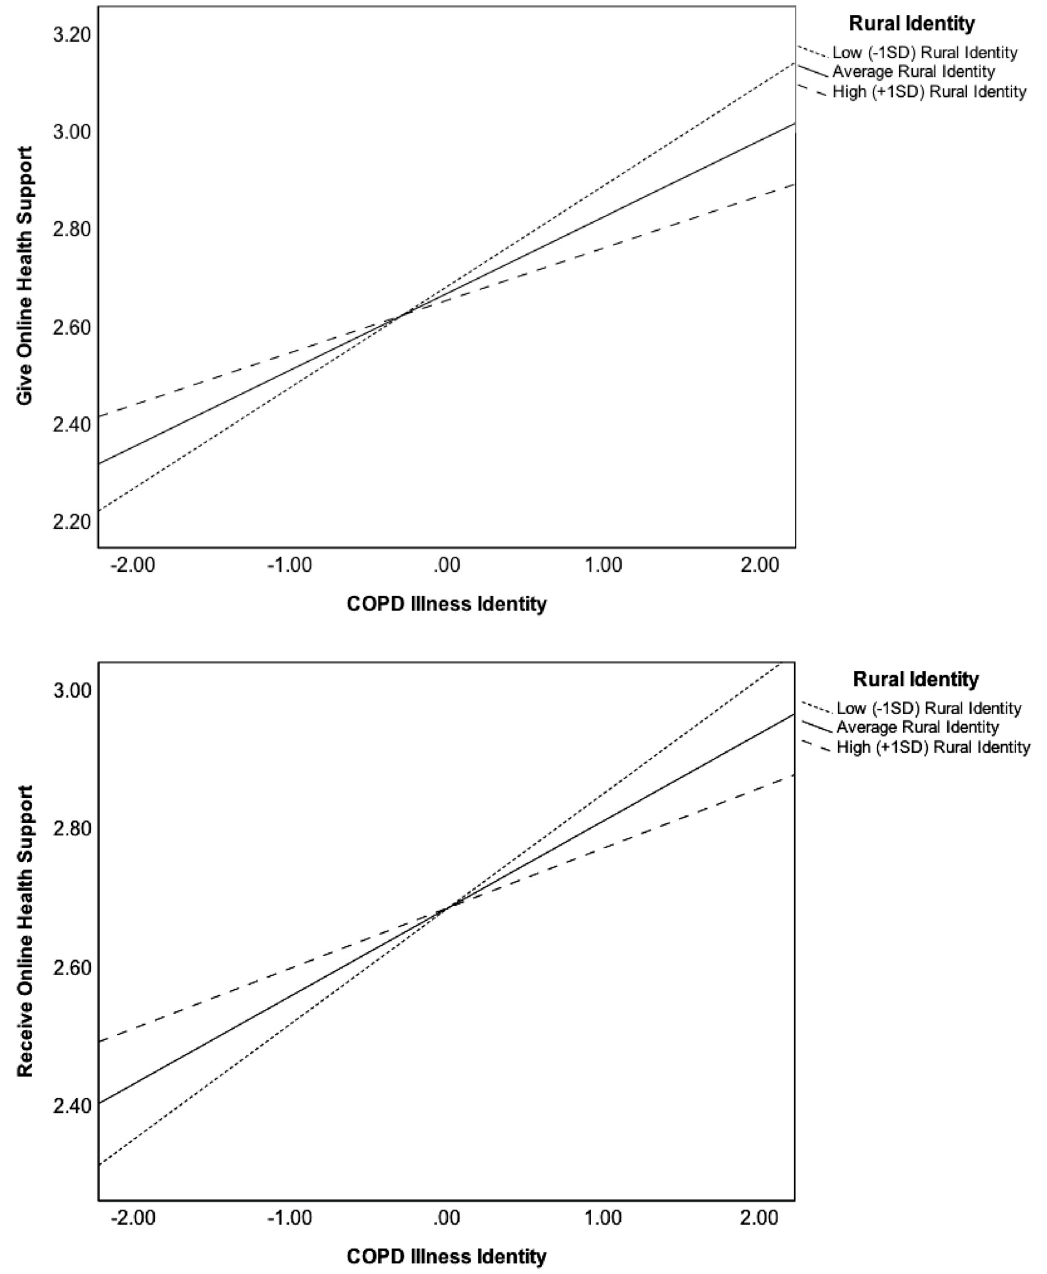
ff ect of rural identity on illness identity and reciprocating online Figure 2. Moderating effect of rural identity on illness identity and reciprocating online support. Figure 2. Moderating e